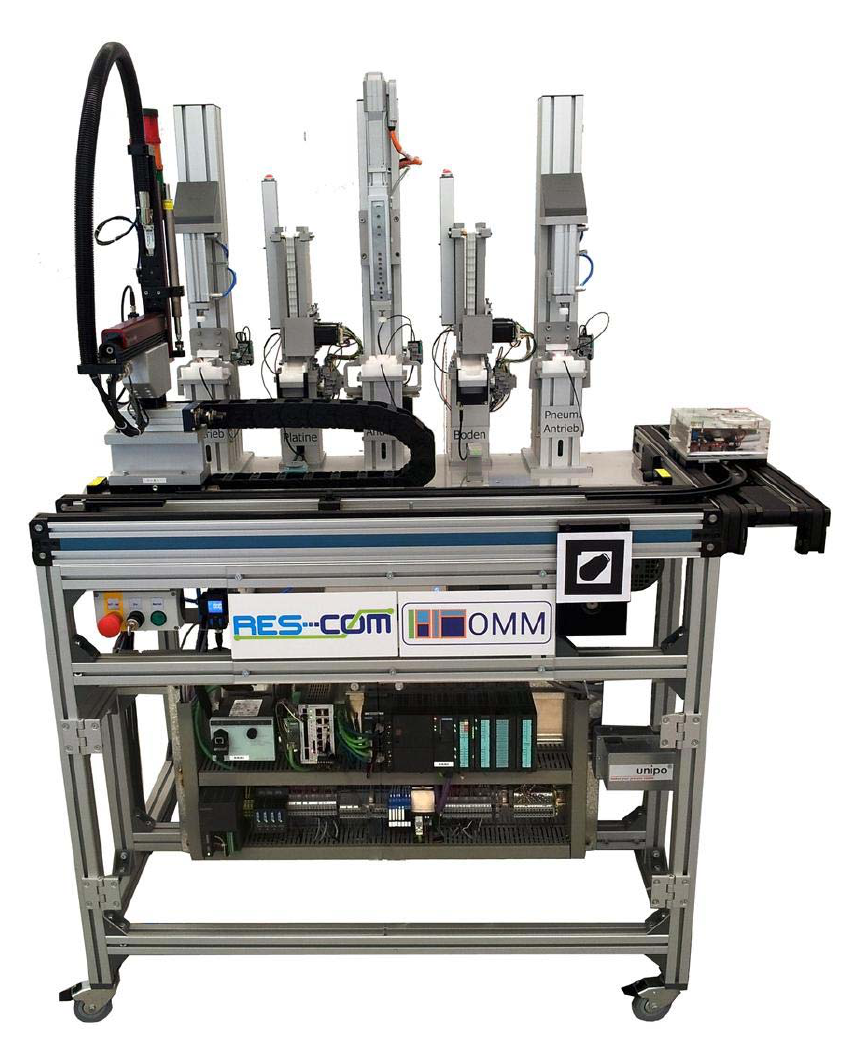
Figure 7. The automated assembly module.